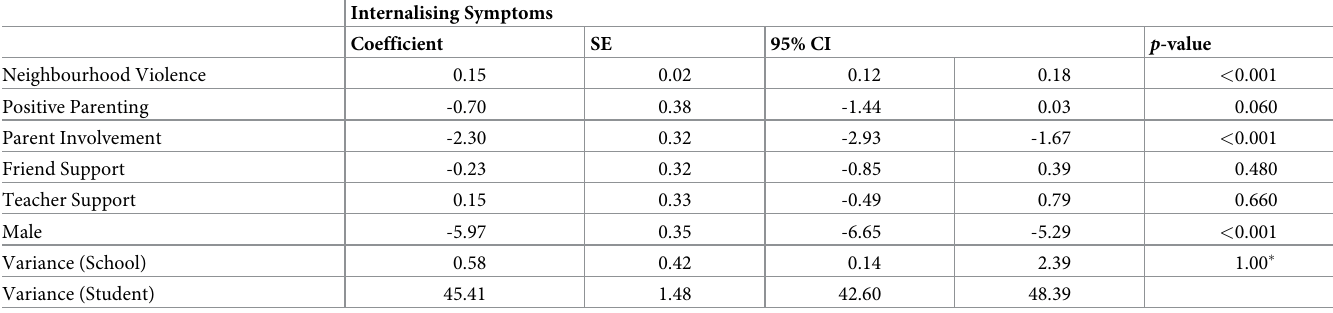
Table 10. Linear mixed-effects models of exposure to community violence & all sources of social support (weighted).